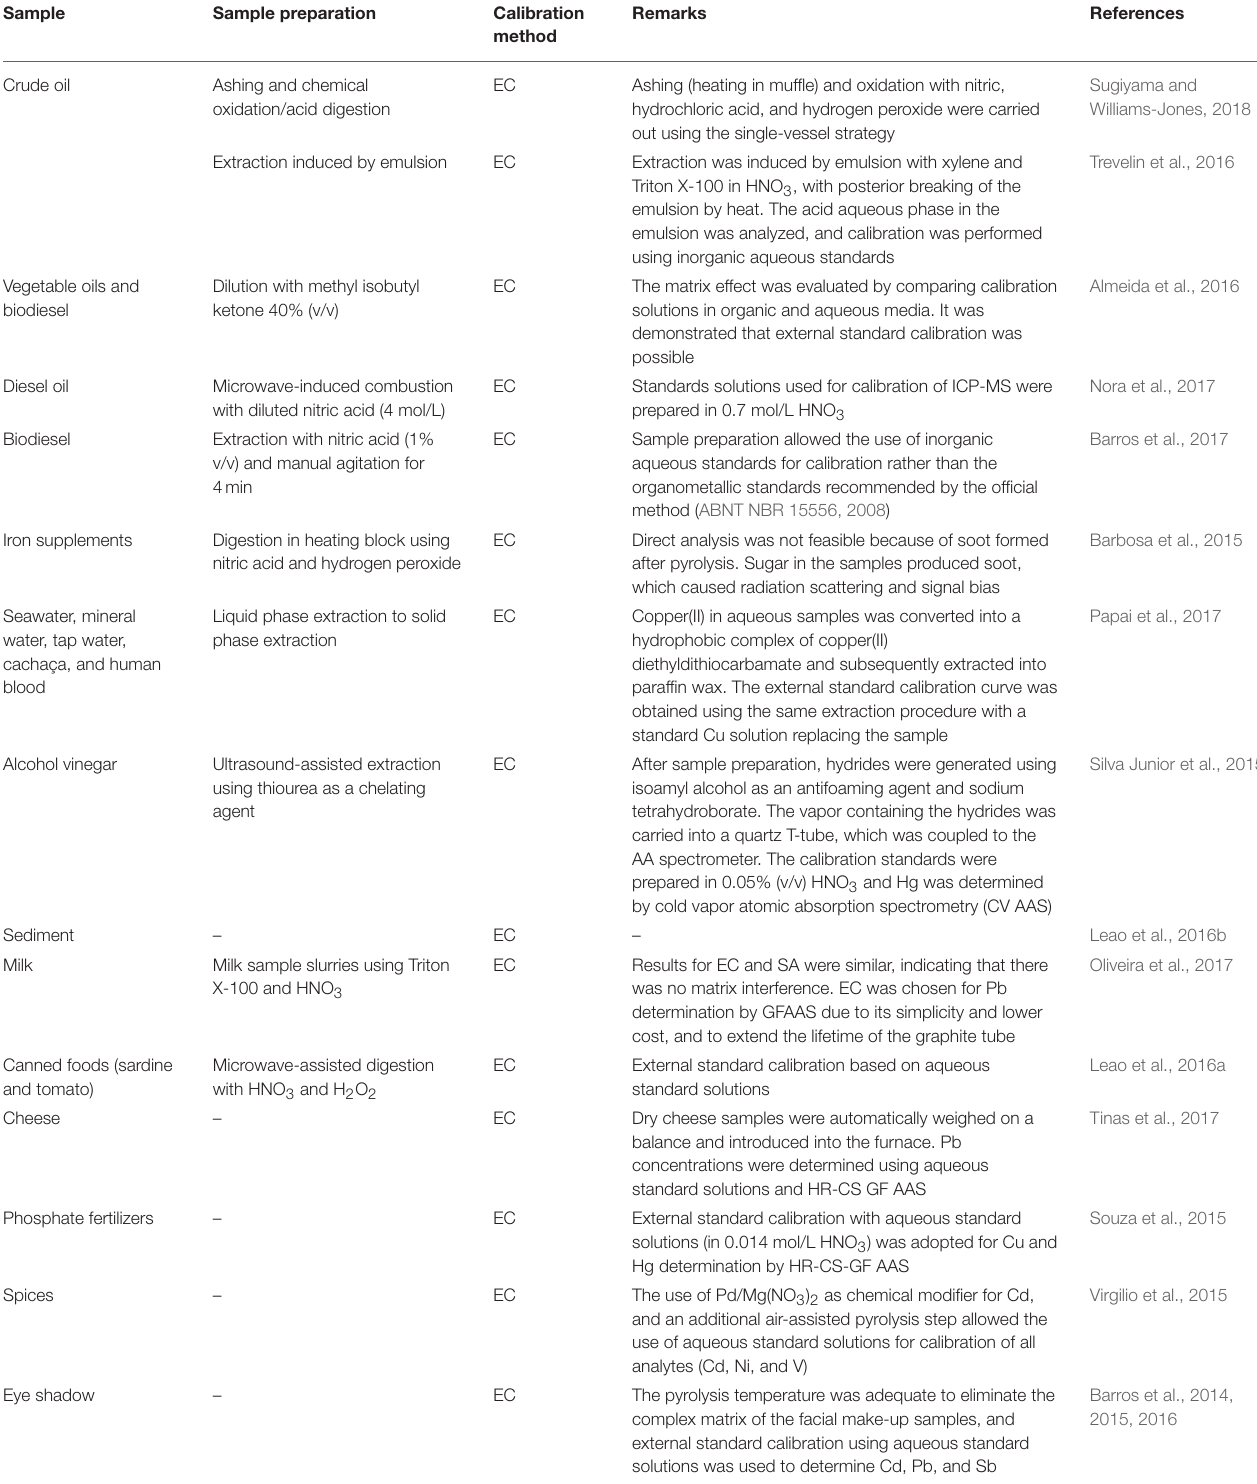
TABLE 1 | Sample preparation procedures and direct sample analysis used in combination with EC or MMC in elemental